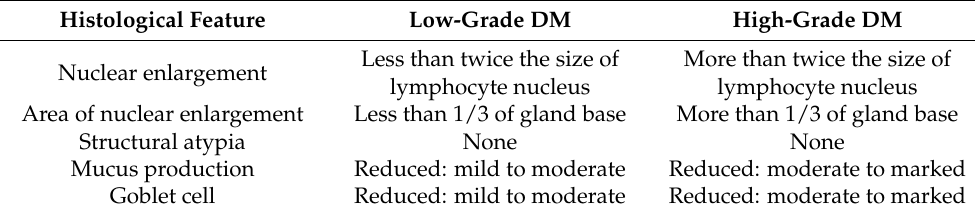
Table 2. Histological diagnostic criteria of high-grade and low-grade DMs.